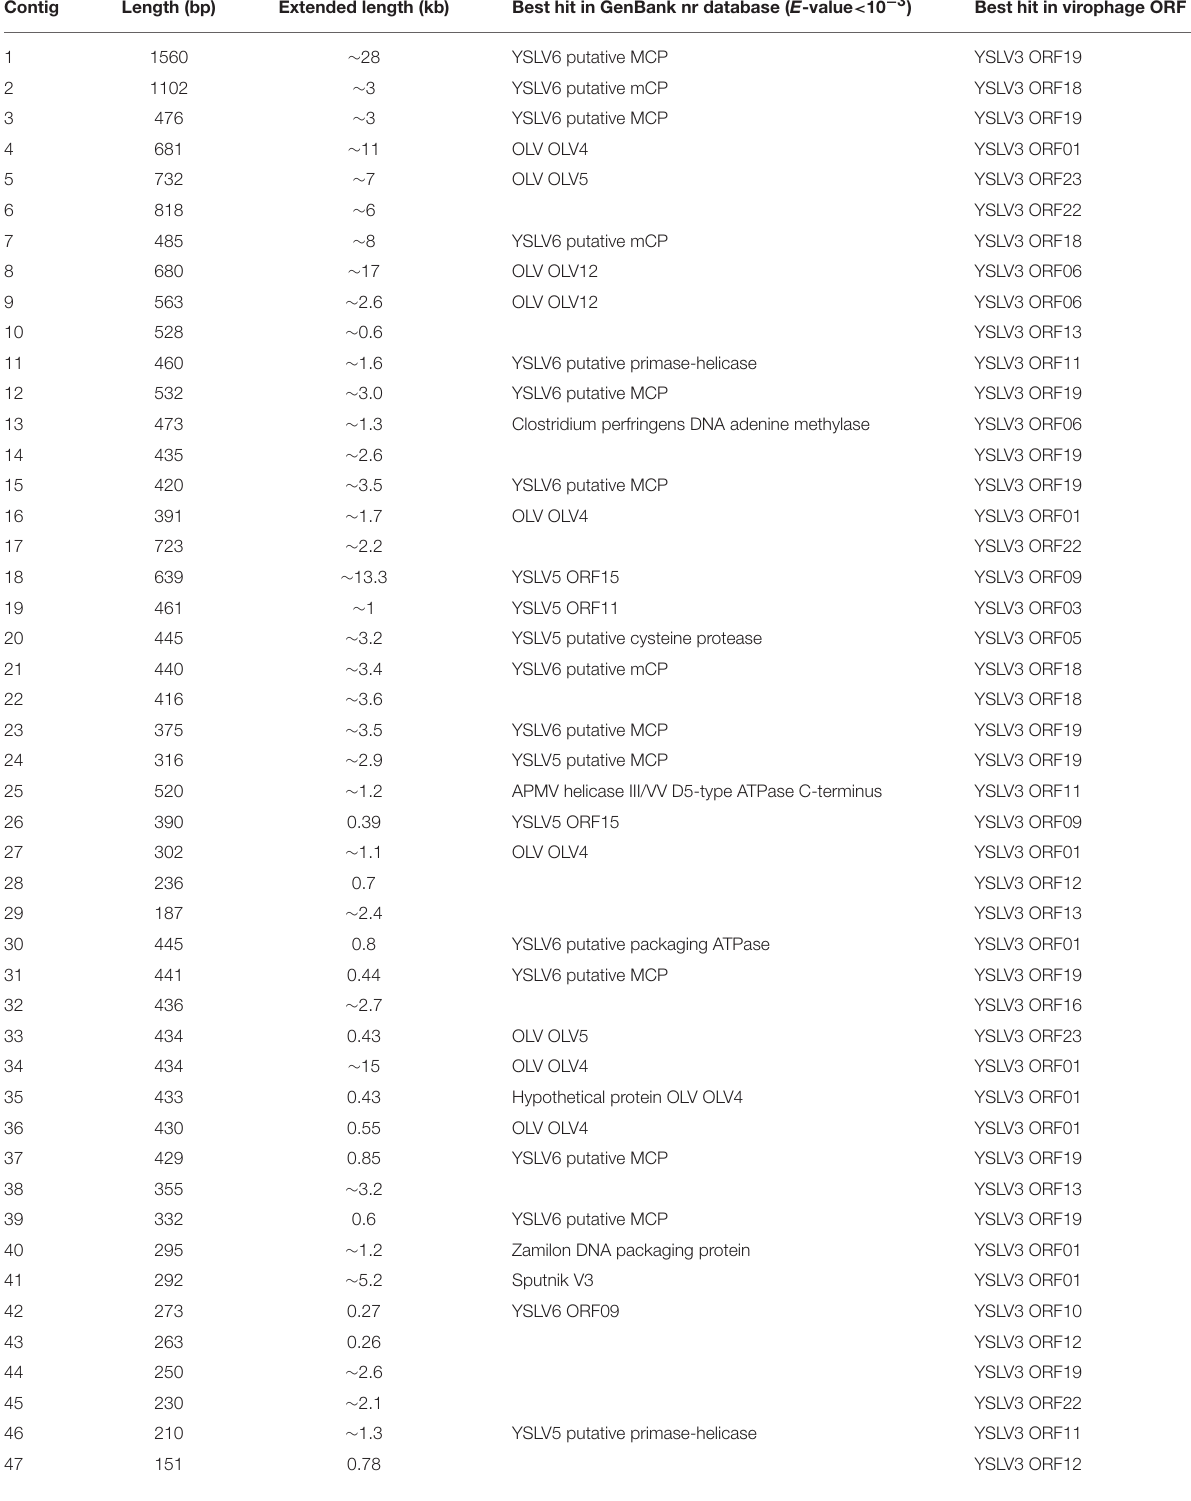
TABLE 6 | Information of the assembled contigs.